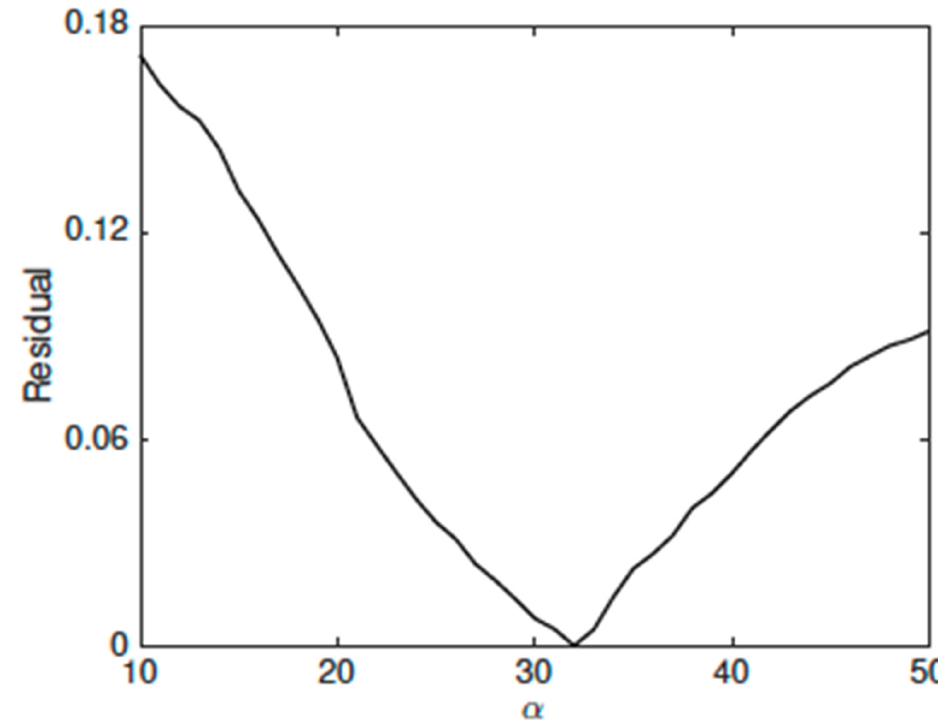
Figure 2. Example of optimization: Residual (Equation (12)) versus α . The solution is determined by the α value that minimizes the residual, which in this example, occurs for α = 31.9 = 100/ π .